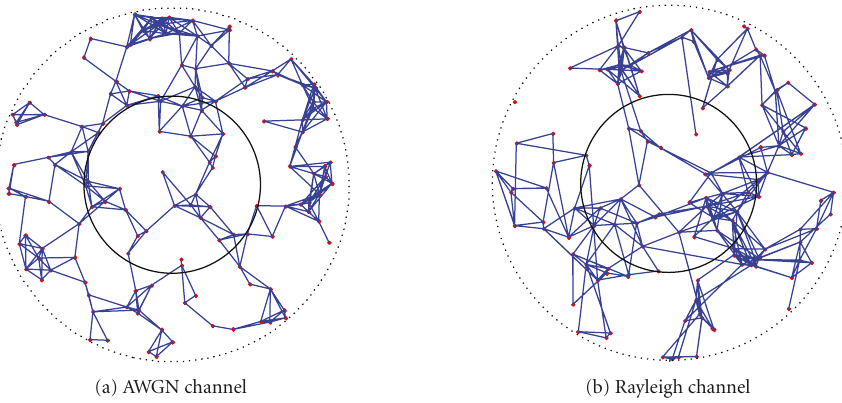
Figure 12: A peculiar realization of graphs is given for (a) AWGN and (b) Rayleigh conditions, with about 50 nodes in the smaller disk. Albeit the mean node degree is constant (equal to 7 . 5), higher length hops in Rayleigh channels make the network better connected.